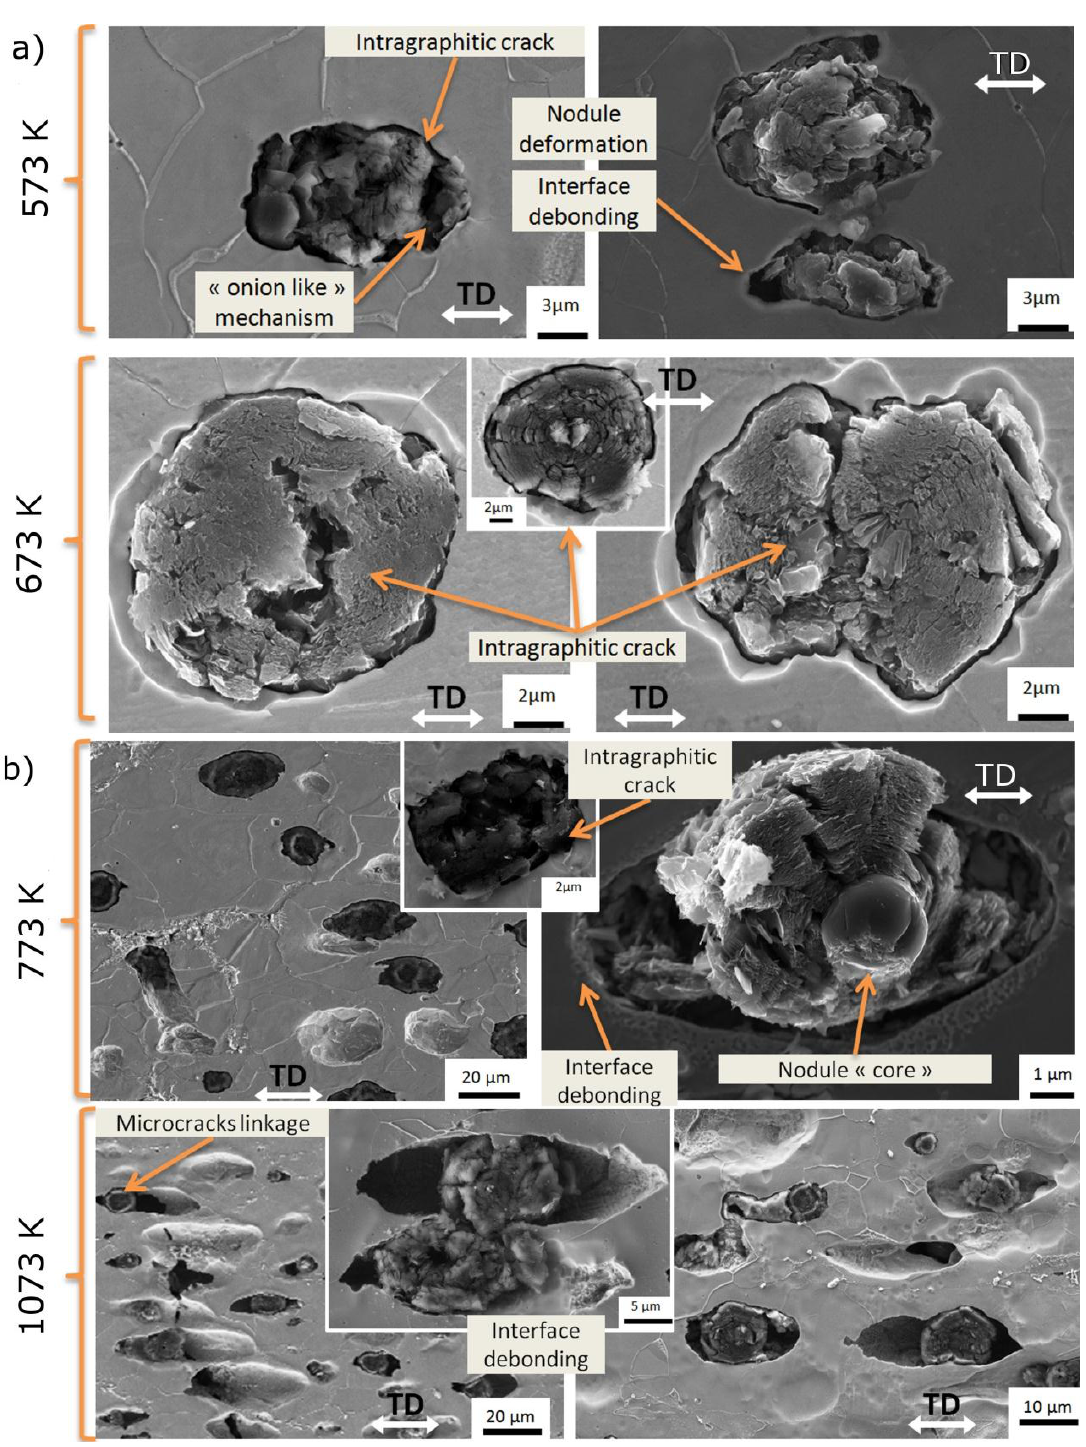
Figure 3. Typical damage mechanisms in tension for temperatures ( a ) lower than 673 K and ( b ) above 773 K after tensile tests (TD, tensile